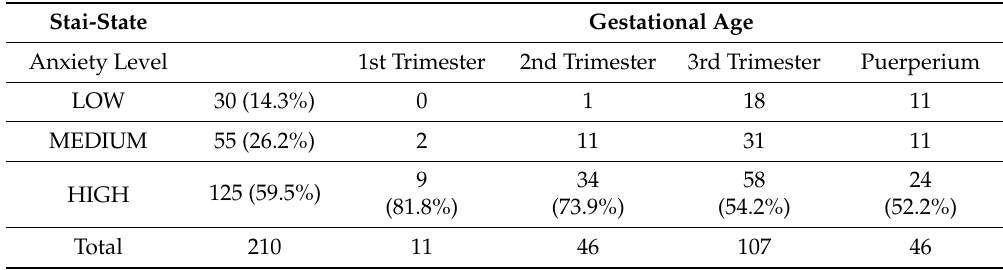
Table 5. The correlation between gestational age and anxiety levels based on STAI-STATE subscale. p =